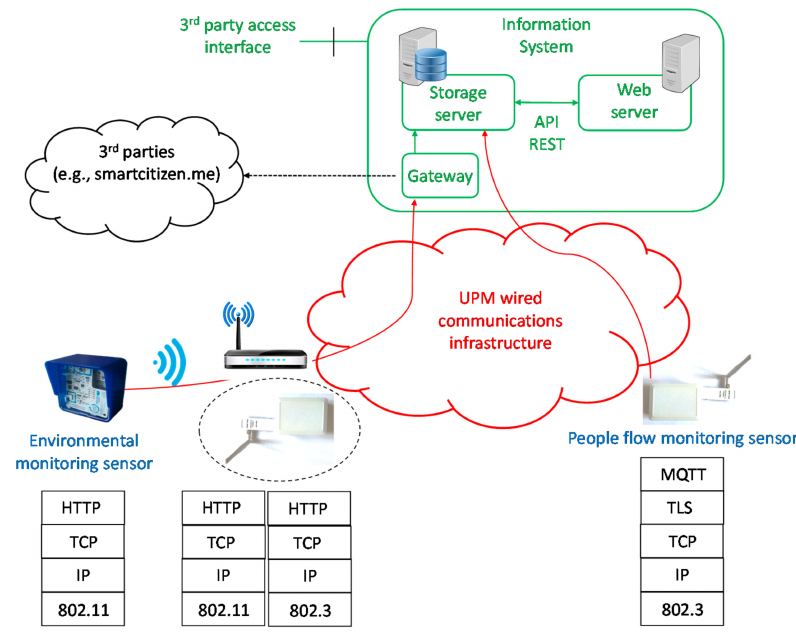
Figure 9. Overview of the communications architecture and protocol stack of the Smart CEI Moncloa